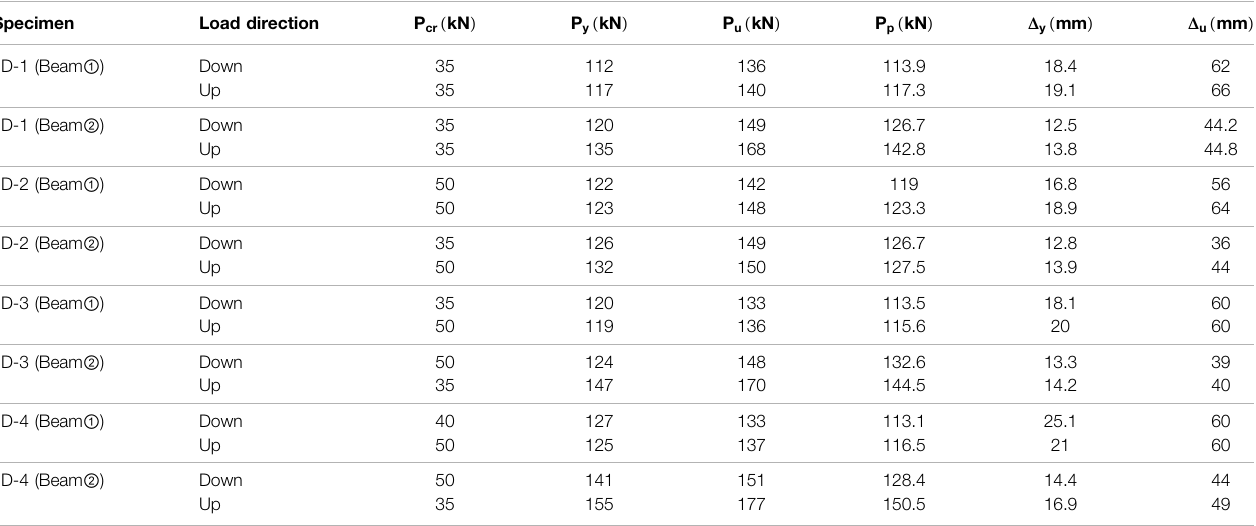
TABLE 5 | Main data of the